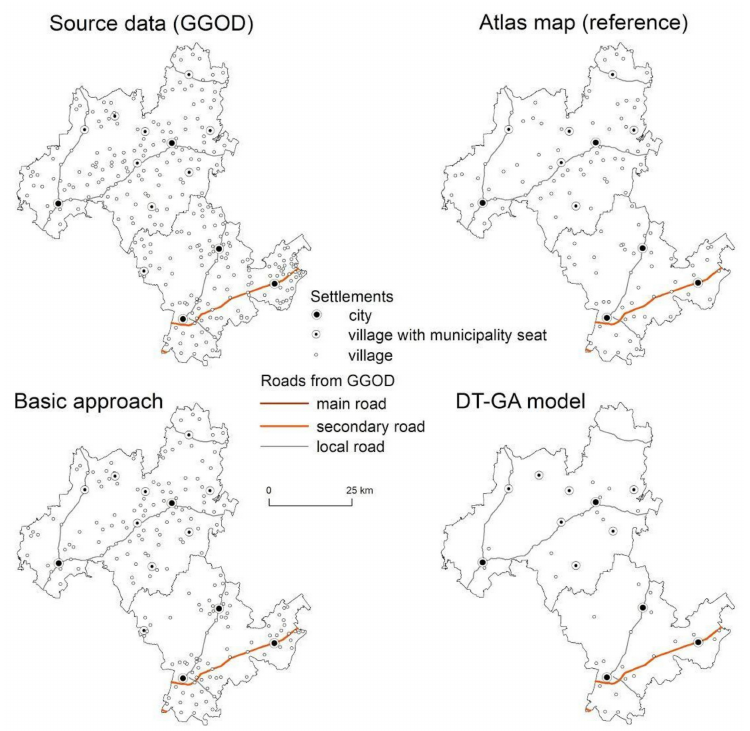
Figure 9. Maps of Bytowski and Chojnicki districts; group 4.